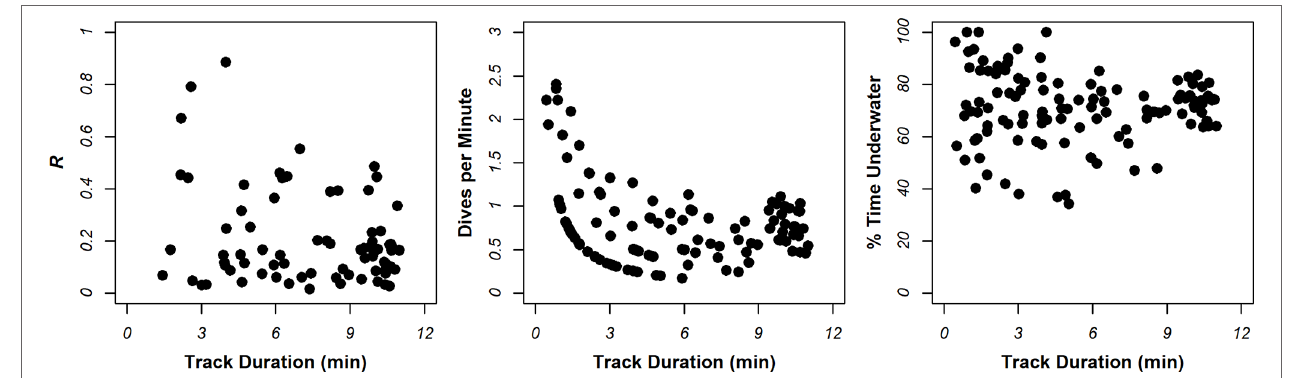
FIGURE 5 | Summary of relationships between dive metrics characterizing foraging intensity and track